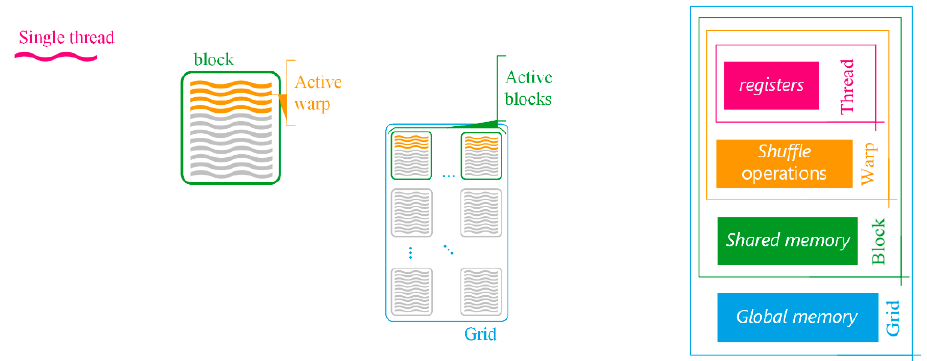
Figure 6. Illustration of the CUDA programming model: threads organization (left) and inter-thread communication mechanisms (right).